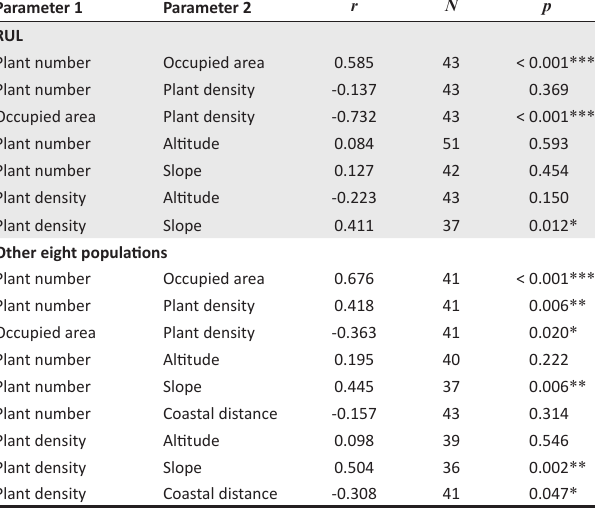
TABLE 2: Spearman rank correlation values for associations among occupied area, plant number and plant density, and two numerical habitat parameters (altitude and slope) at 51 sites in the Rössing Uranium Limited population, and at 43 sites in the other eight